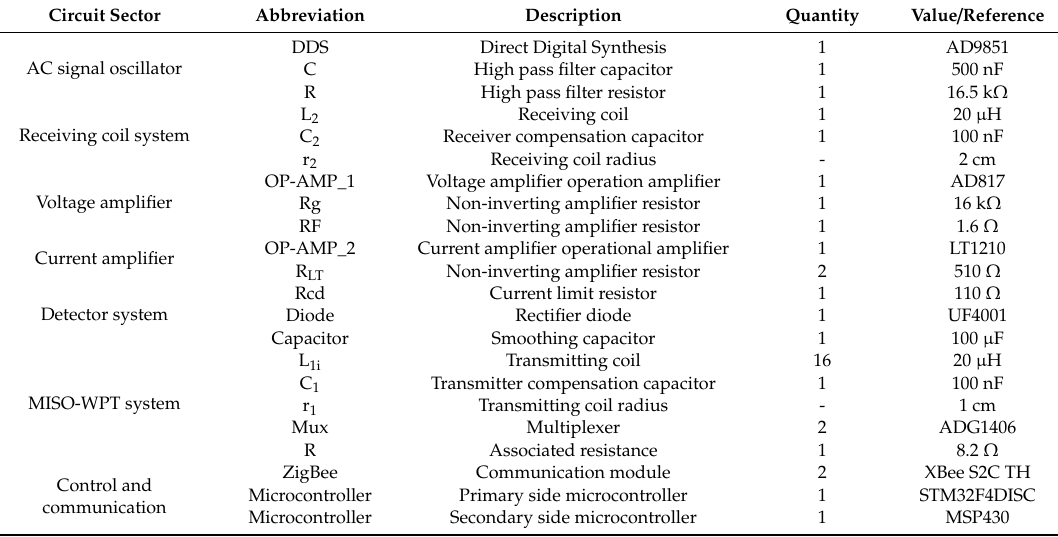
Table 3. Primary and secondary sides components list.